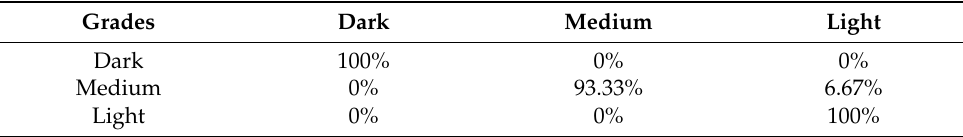
Table 4. Confusion matrix of the test results.